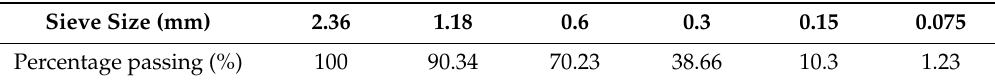
Table 5. The gradation of CRT.